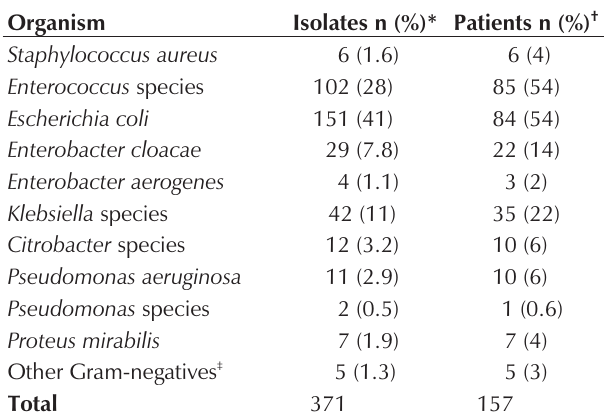
Distribution of organisms detected on gastrointestinal